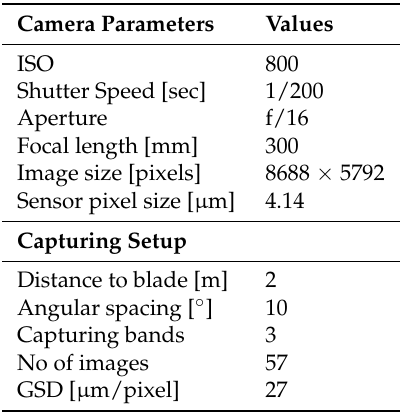
Table 1. Camera parameters and settings for the outdoor capturing